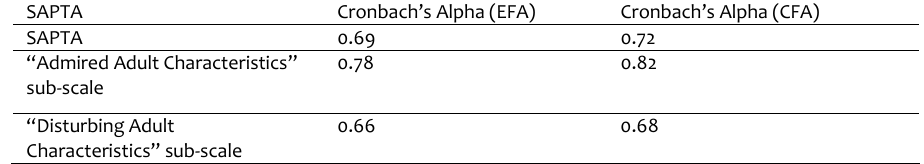
Figure 2. First Level Confirmatory Factor Analysis Linkage Diagram